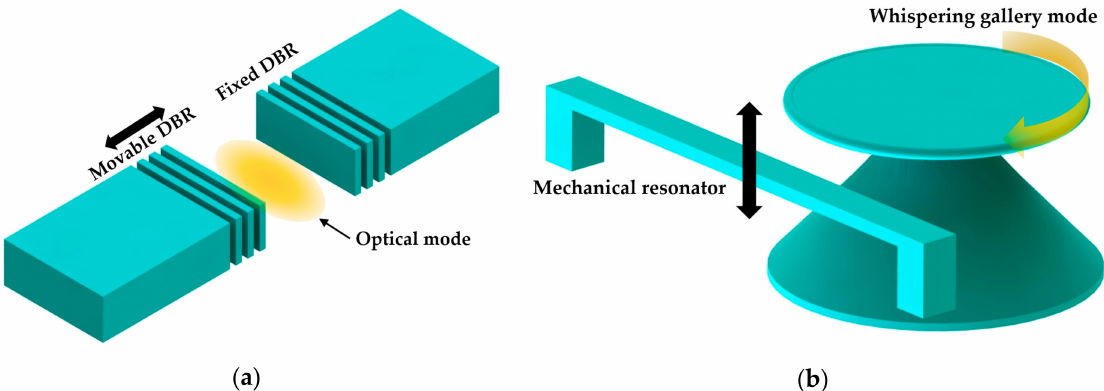
Figure 14. Schematics of typical optomechanical systems based on F-P cavity and WGM cavity: ( a ) an F-P cavity coupled with a mechanical resonator; ( b ) a WGM cavity coupled with a mechanical